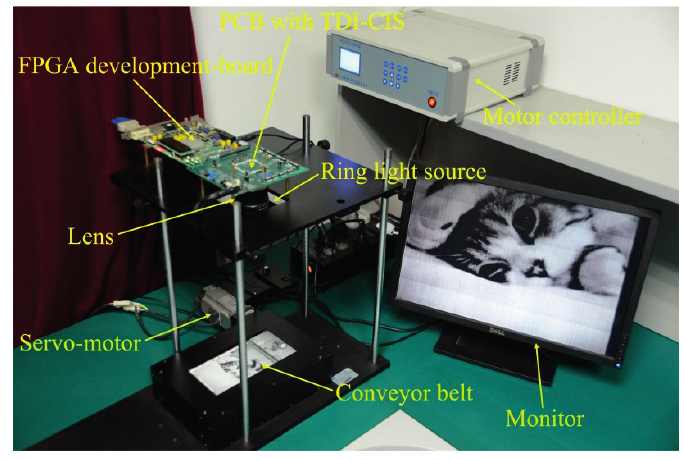
Figure 11. Schematic diagram of the TDI CMOS imaging system.